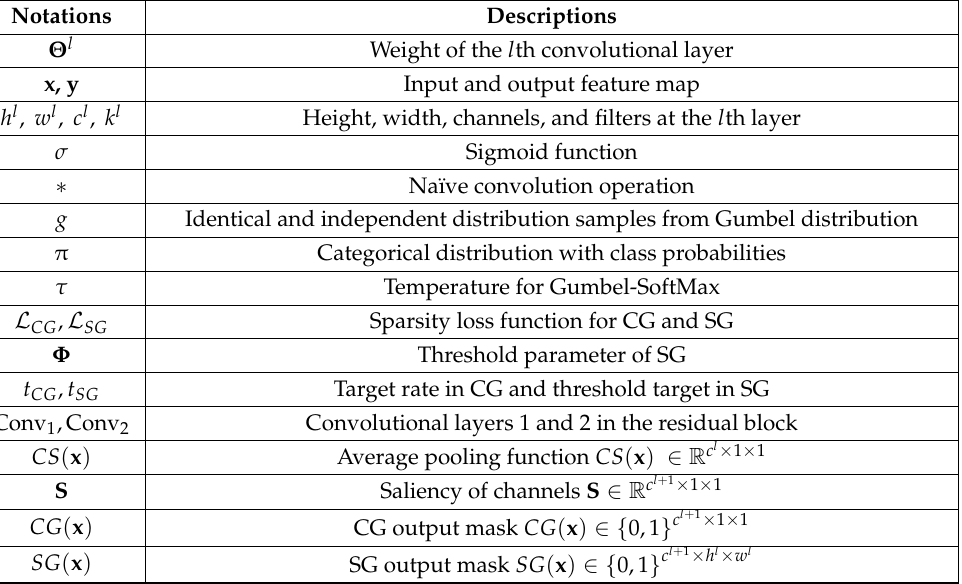
Table 2. Notations used in